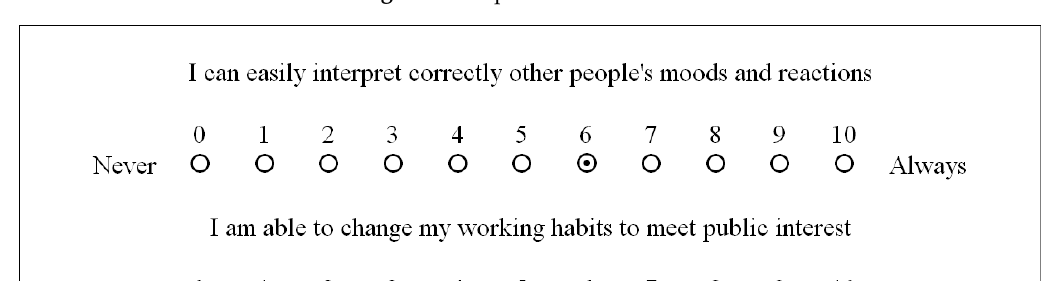
Figure 1. Graphic slider-bar scale.